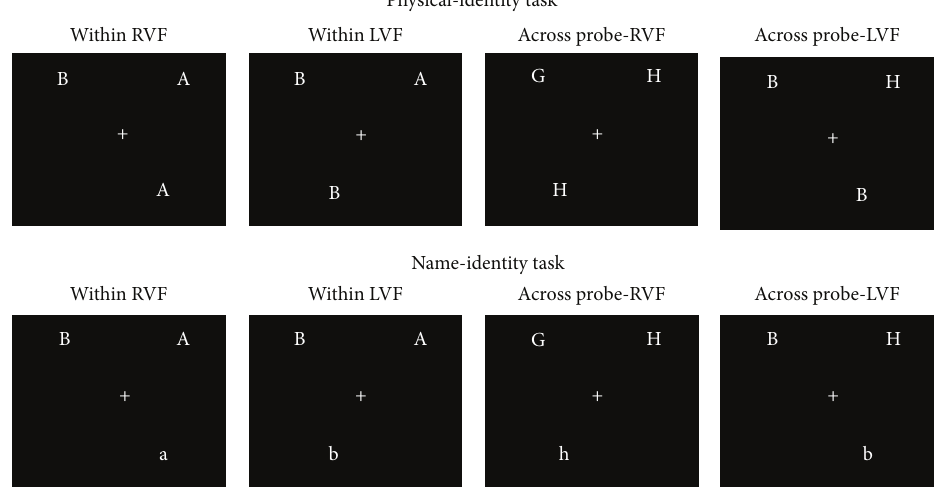
Figure 1: Samples of stimuli in the match trials for each task. LVF = left visual field; RVF = right visual field.